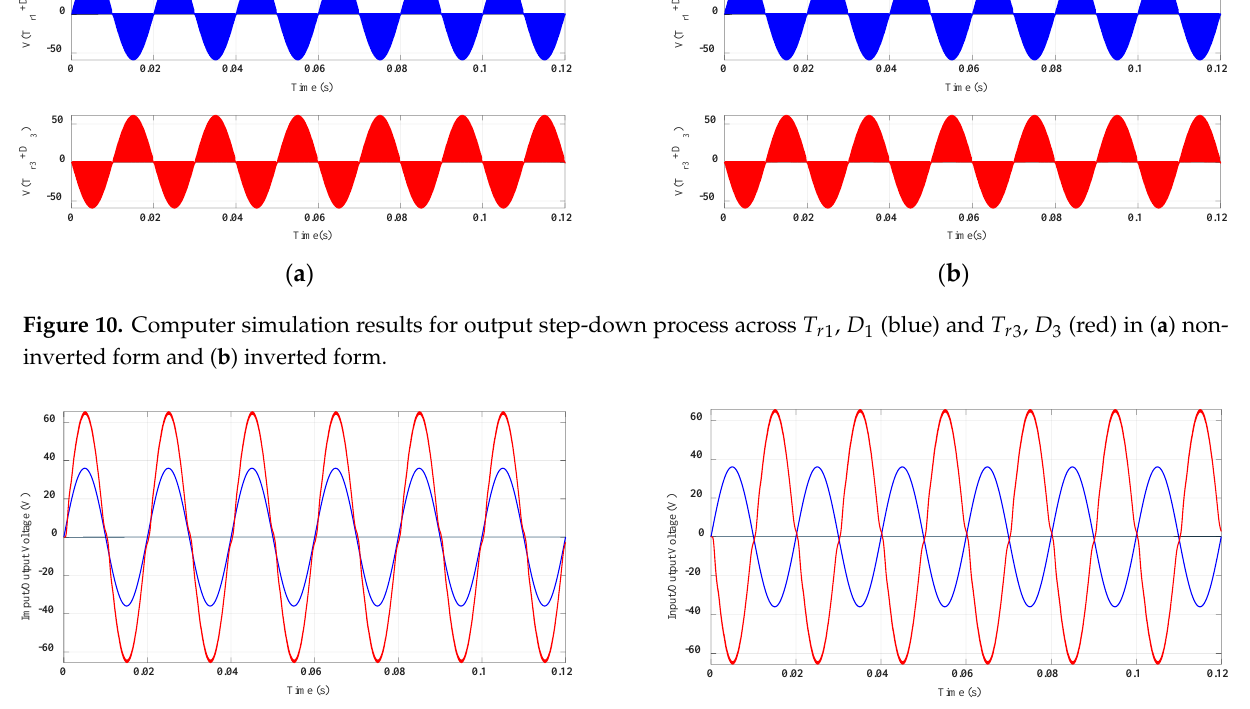
( b ) Figure 12. Computer simulation results for output step-up process across T r 5 , D 5 (blue) and T r6 , D 6 (red) in ( a ) non-inverted form and ( b ) inverted form.